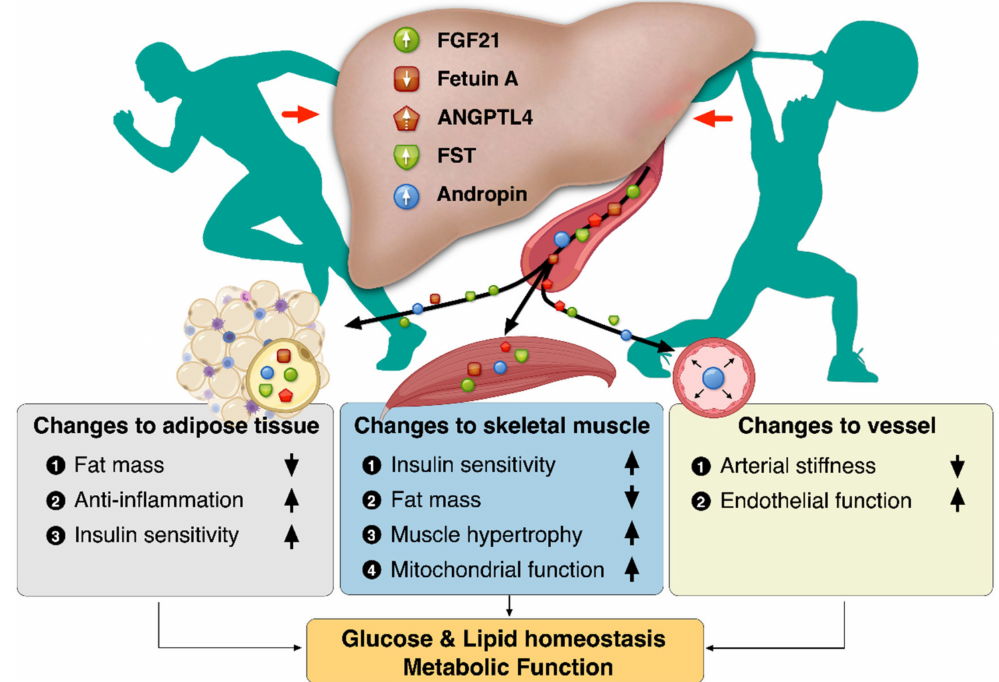
Figure 1. Benefits of exercise-induced hepatokines: changes to the adipose tissue, vessel, and skeletal